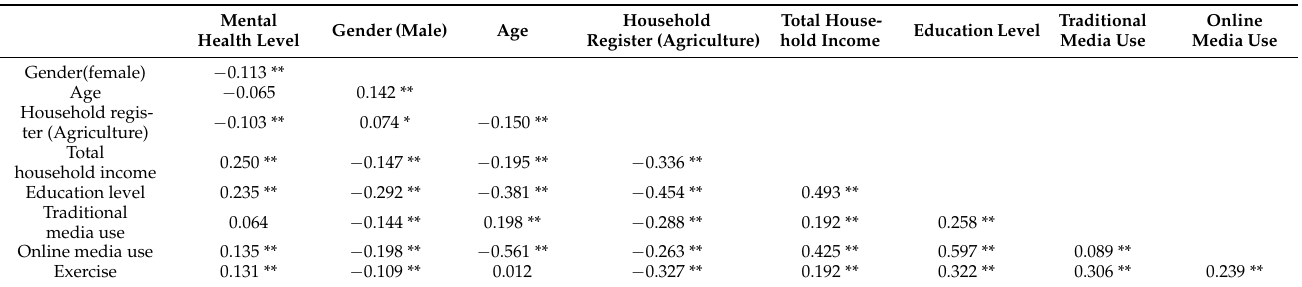
Table 6. Bivariate correlation between mental health level and other